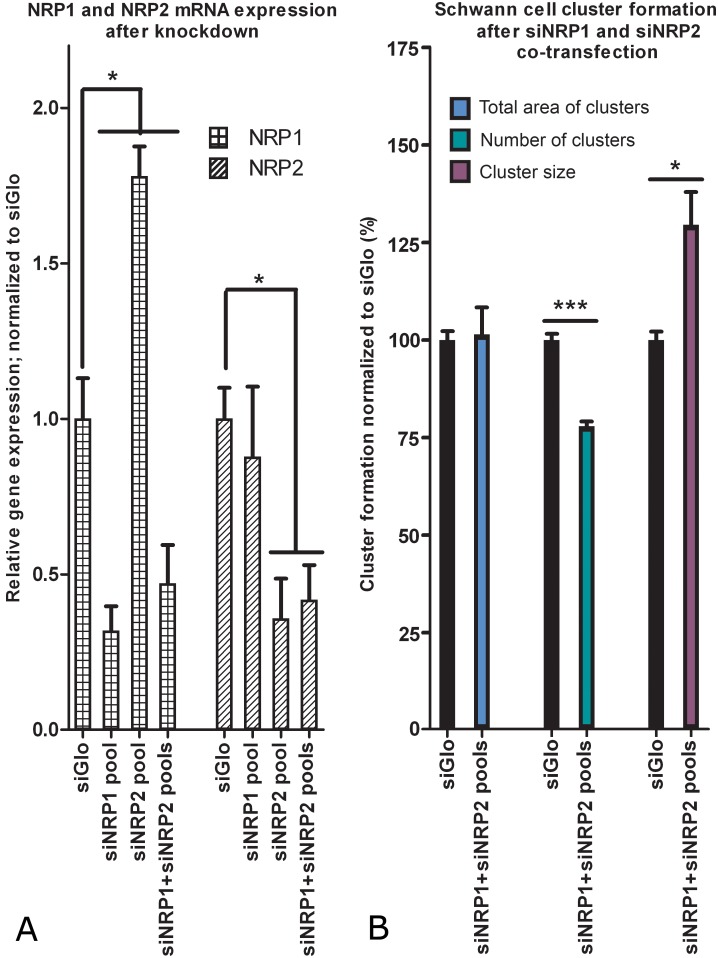
Knockdown of NRP2 expression causes increased mRNA expression of NRP1, while simultaneous knockdown of both NRPs has no effect on the total area of SC clusters.SCs were transfected with the siNRP1 pool, the siNRP2 pool or a combination of both. (A) After 5 days the measured NRP1 mRNA expression levels were 32, 178, and 47% respectively when compared to the siGlo condition. This indicates NRP1 mRNA upregulation after knockdown of NRP2. mRNA expression levels of NRP2 after knockdown with the siNRP1 pool, the siNRP2 pool or a combination of both were 88, 36 and 42% of endogenous levels respectively. The presented values are averages of 4 independent SC transfections (p<0.05). (B) A simultaneous transfection with the siNRP1 and siNRP2 pool has no effect on the total area of SC clusters. There is a small but significant decrease in the number of clusters (78%; p<0.001) and a moderate increase in cluster size (130%; p<0.05). The presented values are averages of 3 independent experiments (P<0.05). Error bars indicate the SEM.